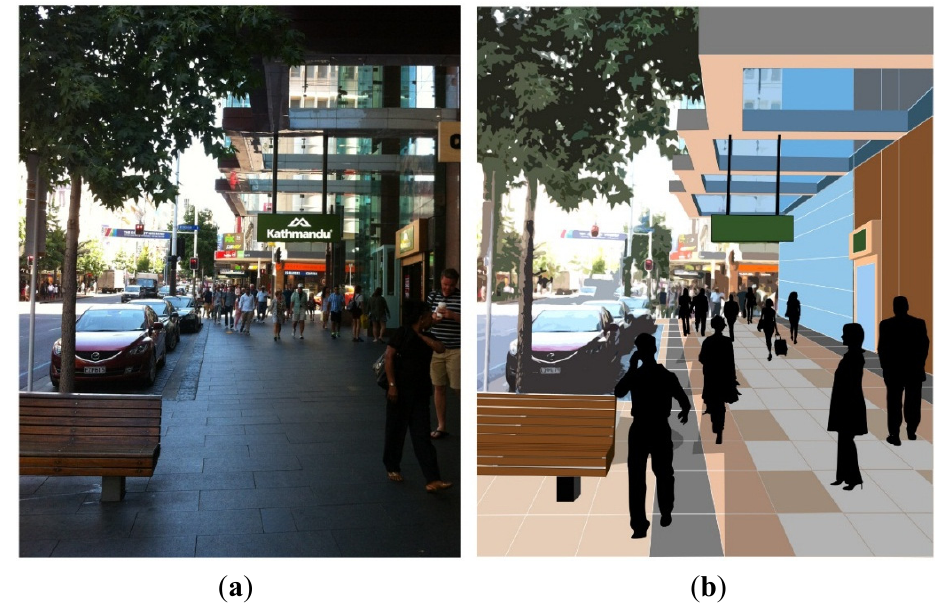
Figure 2. Conceptual intervention of cool pavements in Queen Street ( a ) Before the installation of cool pavements; ( b ) Post intervention. Source: Author’s